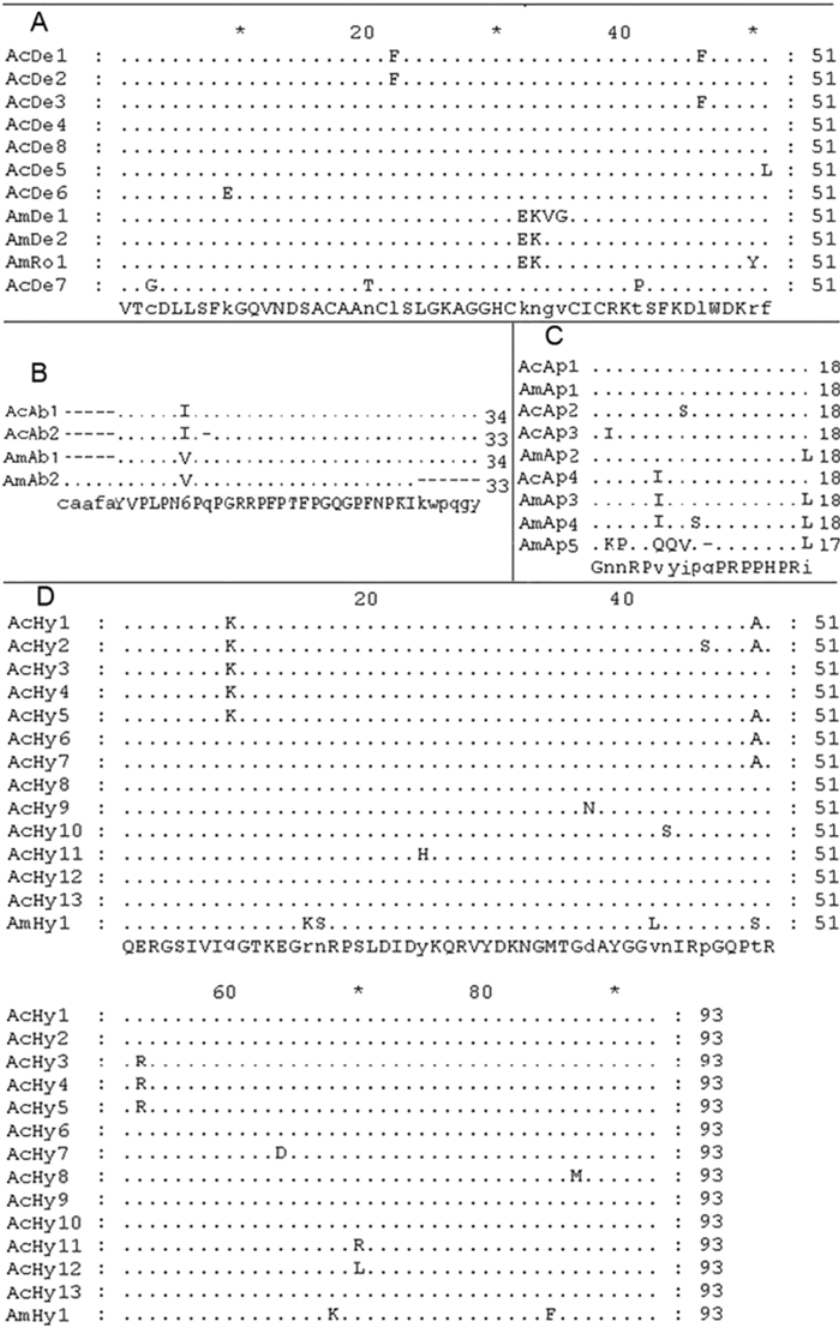
Figure 1. Alignment of mature peptides of the four antimicrobial peptide families of A.cerana and A.mellifera . (A) : Alignment of mature peptides of honeybee defensins. AcDe1 to AcDe8 from the Asiatic honeybee; AmDe1, AmDe2 and AmRo1 from the Western honeybee, AcDe8, AmDe1, AmDe2 and AmRo1 downloaded from the NCBI website. (B) : Alignment of mature peptides of honeybee abaecins. AcAb1 and AcAb2 from the Asiatic honeybee; AmAb1 and AmAb2 from the Western honeybee and downloaded from the NCBI website. (C) : Alignment of mature peptides of honeybee apidaecins. AcAp1 to AcAp4 from the Asiatic honeybee; AmAp1 , AmAp5 from the Western honeybee and downloaded from the NCBI website. (D) : Alignment of mature peptides of honeybee hymenoptaecins. AcHy1 , AcHy13 from the Asiatic honeybee; AmHy1 from the Western honeybee and downloaded from the NCBI website. Multiple sequence alignment performed using Clustal_X. Identical amino acids are in black dots. Different amino acids are shown in the alignment. Small dashes indicate gaps inserted for optimal alignment. Amino acid residues are numbered on the right.